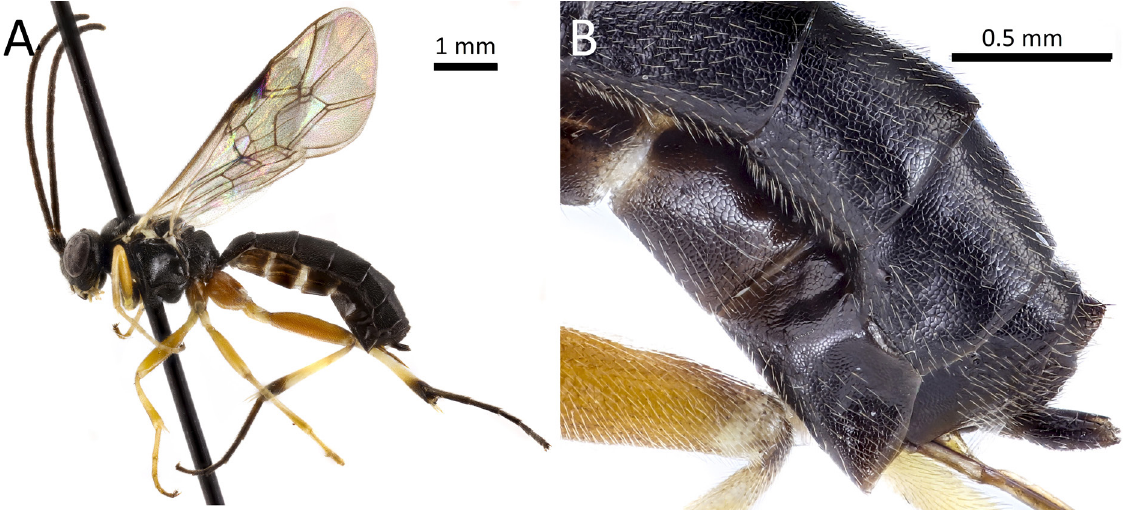
Fig. 2. Homotropus hellqvisti sp. nov., paratype, ♀ (NHRS-HEVA000011637). A . Habitus, lateral view. B . Posterior segments of